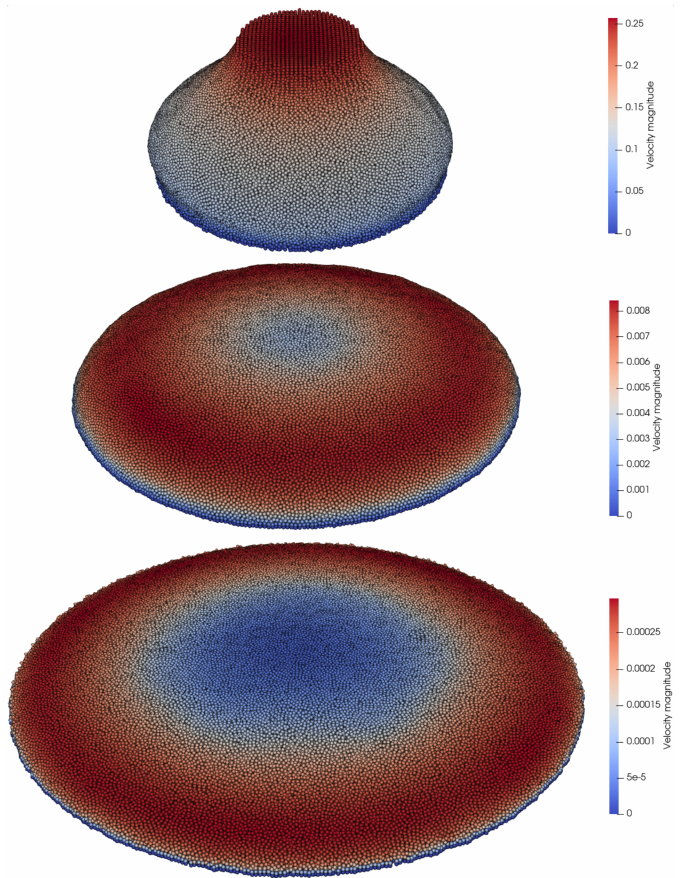
Figure 11. Simulation snapshots for three time instances t = 0.5, 5.0, 40.0s with plotted veloc- ity